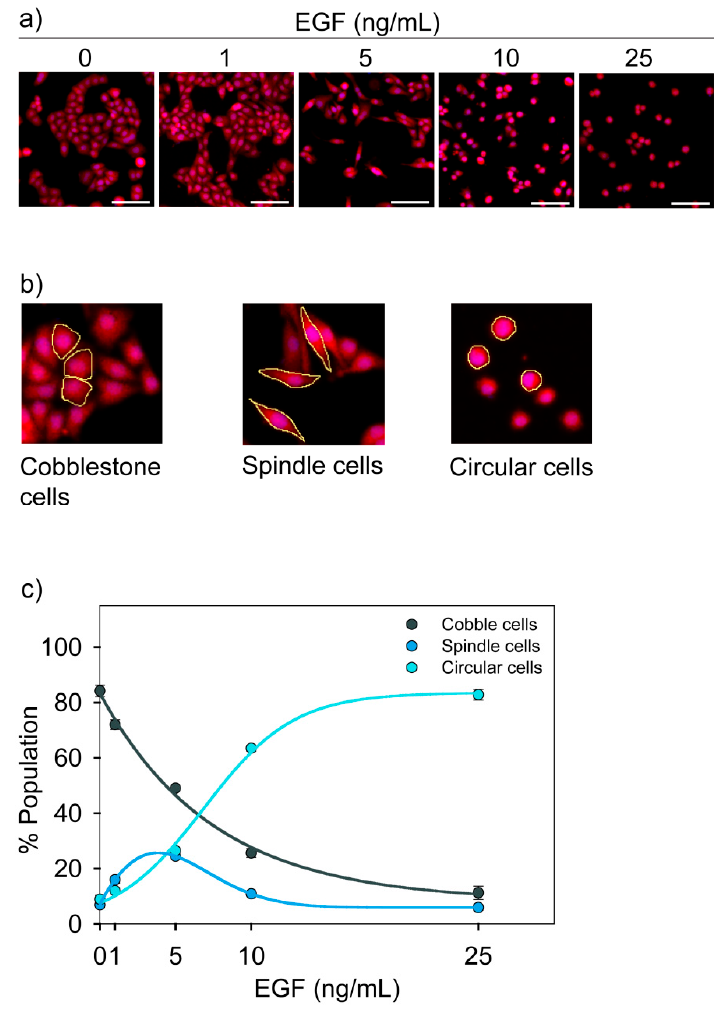
Figure 2. EGF-induced change in morphology of MDA-MB-468 cells. Cells were treated with different doses of EGF for 24 h, and the change in morphology was imaged by fluorescence microscopy. ( a ) Representative images for each dose of EGF show the dose-dependent effect of EGF on the morphology. Scale bar: 100 µm. ( b ) Cells with three distinct morphologies were observed. These are named as cobblestone, spindle and circular. Typical cell types in each category are highlighted by the yellow line. ( c ) EGF-induced change in population distribution. The graph represents quantitative data from image analysis. Each data point represents the mean of three independent experiments and error bars indicate standard deviation.